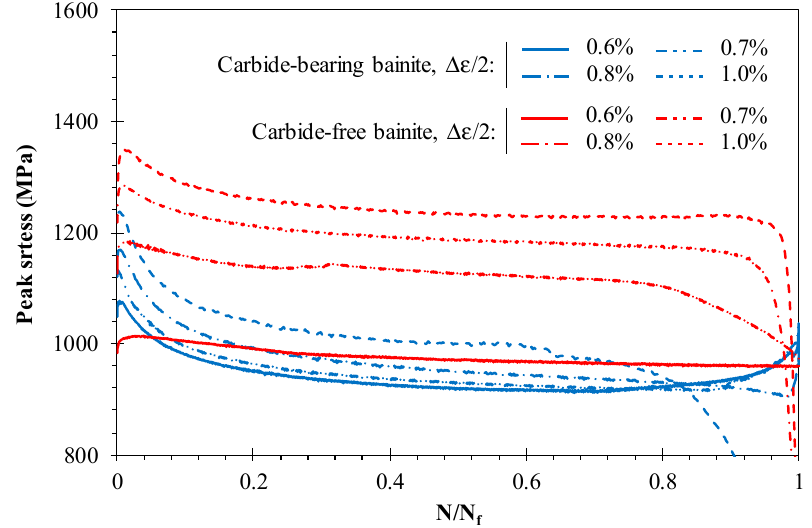
Figure 2. Variation of peak stress with the normalised fatigue life for both carbide-bearing and carbide-free bainitic steels at different strain amplitudes under fully-reversed strain-controlled conditions.